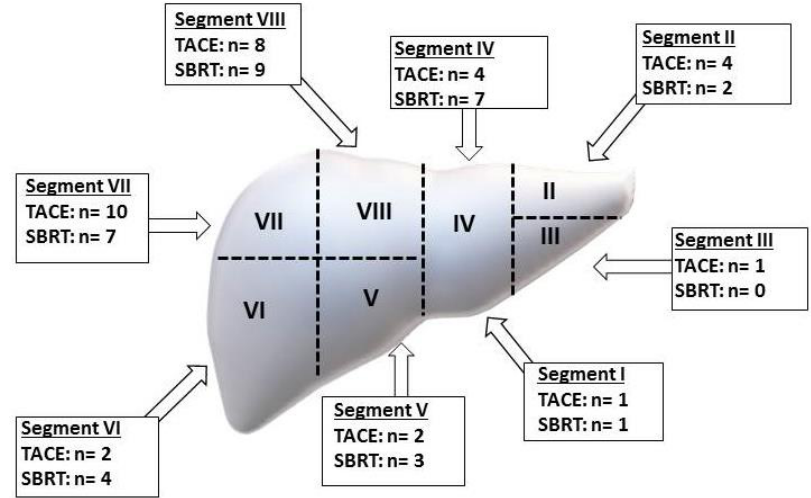
Figure 2. Tumor locations of treated lesions.